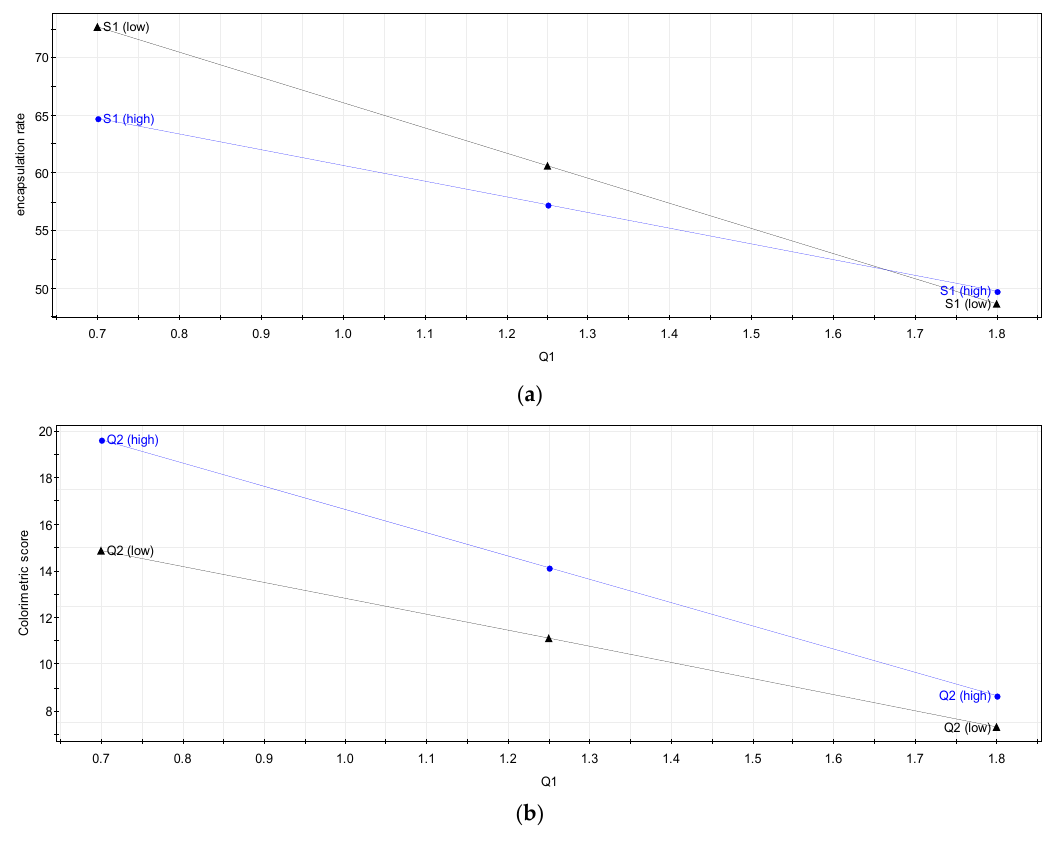
Figure 5. Interaction graph between ( a ) (cid:1843) (cid:2869) × (cid:1845) (cid:2869) and ( b ) (cid:1843) (cid:2869) × (cid:1843) (cid:2870) .